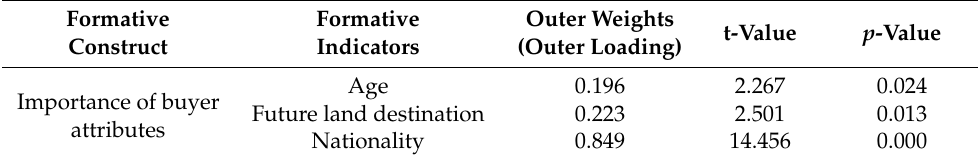
Table 4. Measurement formative construct.